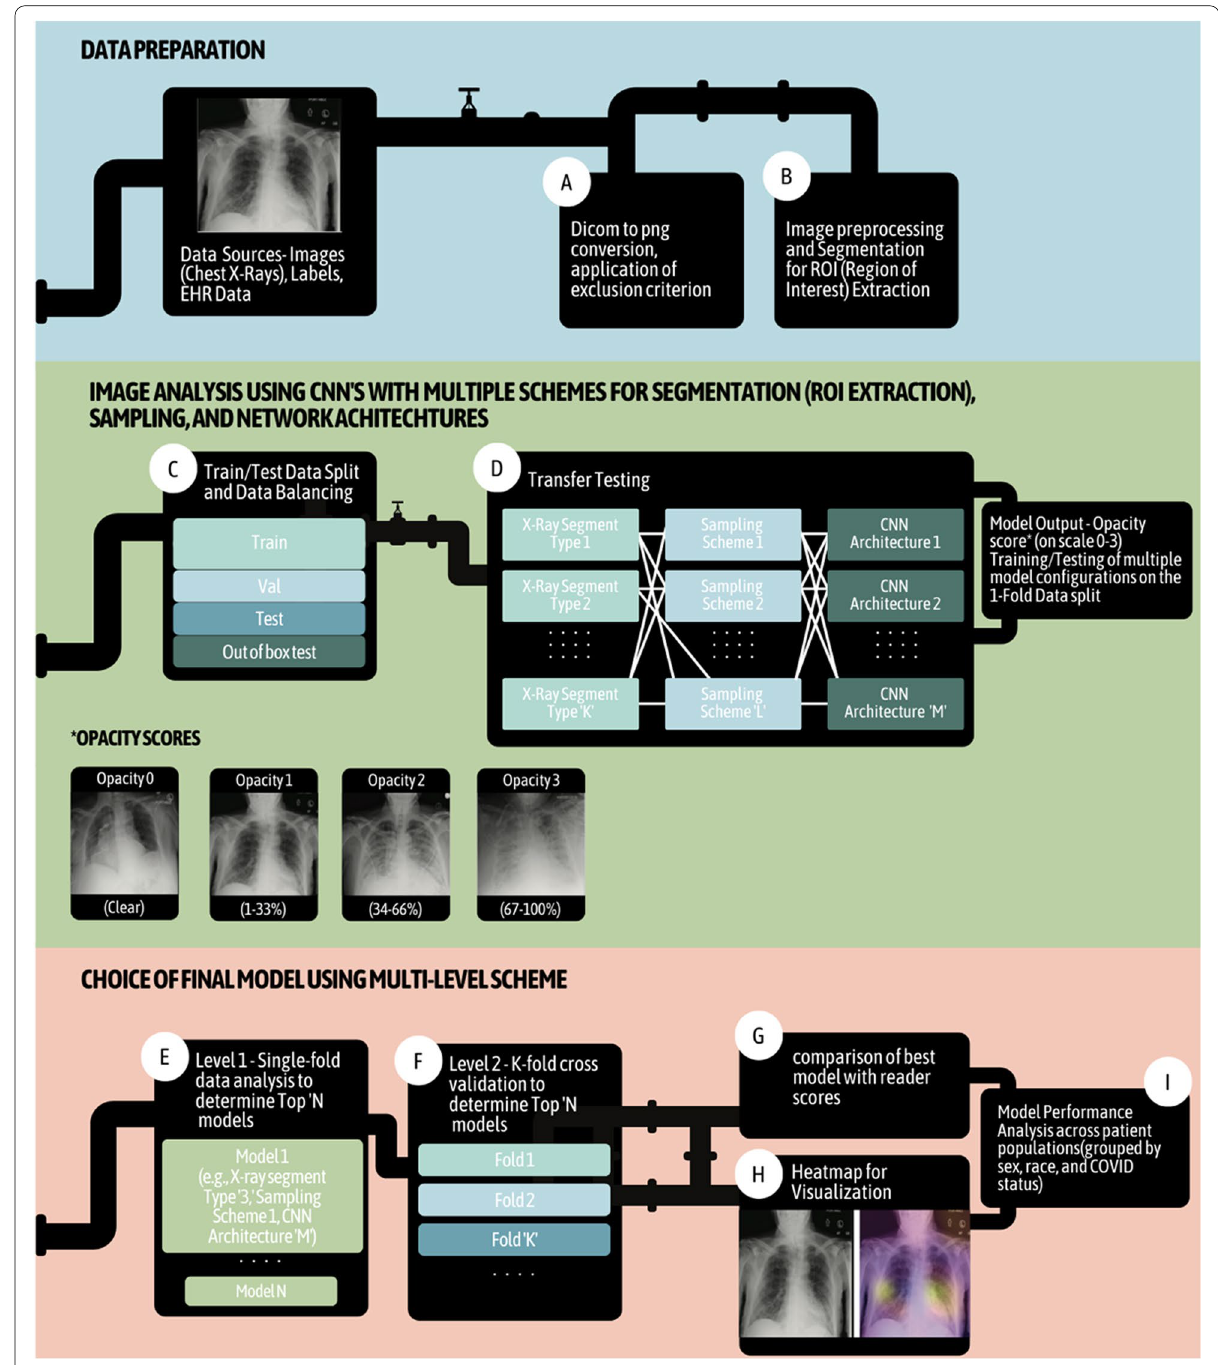
Fig. 1 Schematic of the proposed pipeline. The different steps of the pipeline are denoted with letter from A–I. Overall pipeline of CXR framework for scoring opacity using deep learning. Steps include ( A ) Data Preparation: DICOM to PNG conversion and application of exclusion criteria; ( B ) image preprocessing and ROI extraction; ( C ) train/test data split and data balancing; ( D ) transfer learning setup for testing models generated using multiple combinations of X-ray segmentation schemes, sampling schemes to overcome dataset bias, and CNN architectures; ( E ) level 1 – single-fold analysis to determine top ‘N’ models; ( F ) level 2 – K-fold cross validation to determine best model; ( G ) comparison of best model with reader scores; ( H ) heatmap for visualization; and ( I ) model performance analysis across different patient populations, grouped by sex, race, and COVID-19